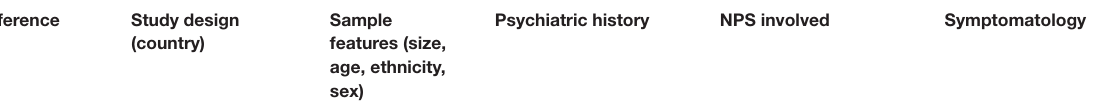
TABLe 2 | Summary of included